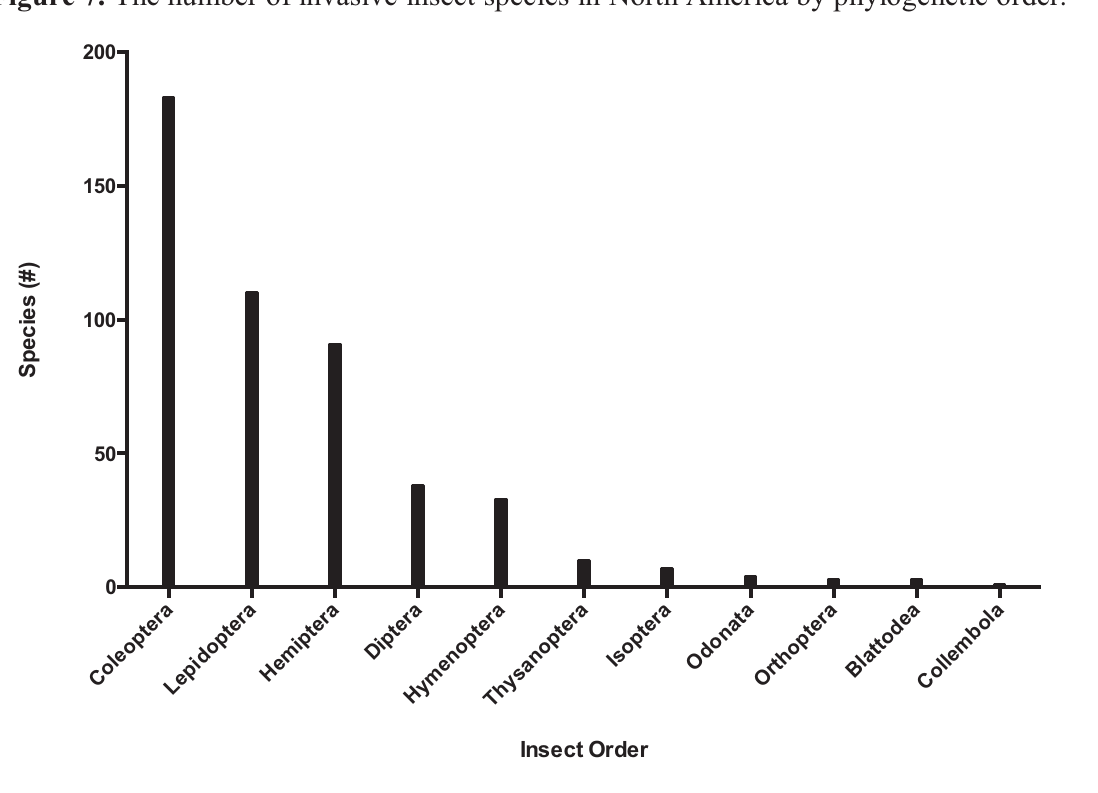
Figure 7. The number of invasive insect species in North America by phylogenetic